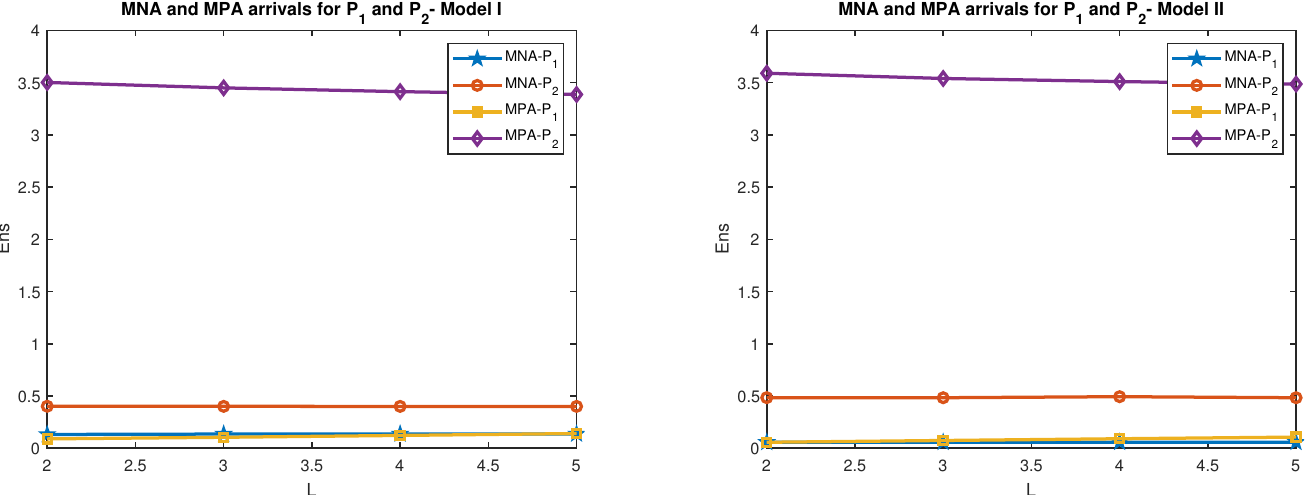
Figure 1. Effect of L on expected number of P 1 and P 2 customers in the system for MNA and MPA arrival processes with correlation of − 0.4211 and 0.4211, respectively(when θ = 0.6).